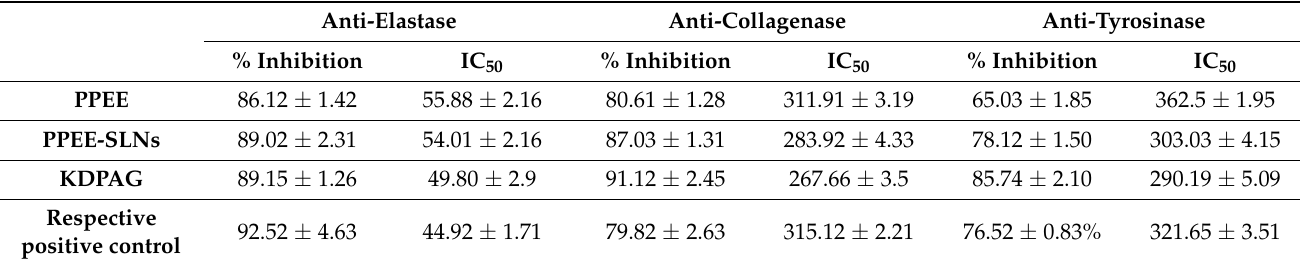
Table 3. Effect of 300 µ g/mL tested samples on the% inhibition along with the IC 50 ( µ g/mL) of the different skin-related enzymes relative to their respective positive